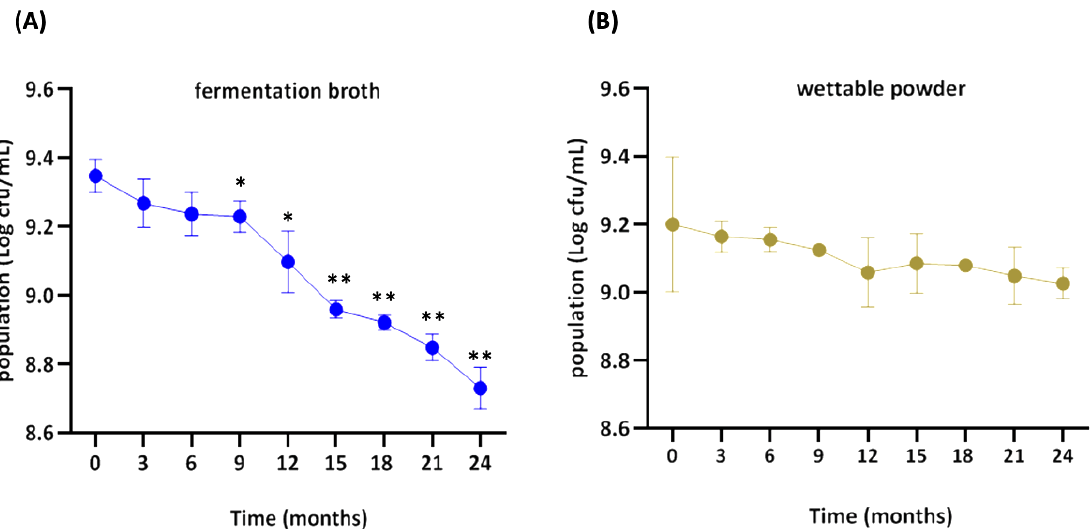
Figure 4. Survival of Bacillus amyloliquefaciens PMB01 strain in liquid fermentation broth ( A ) or wettable powder ( B ) in 24 months. The population of PMB01 was determined every three months, compared with the initial population, and analyzed statistically by Student’s t -test (*, p < 0.05; **, p < 0.01).